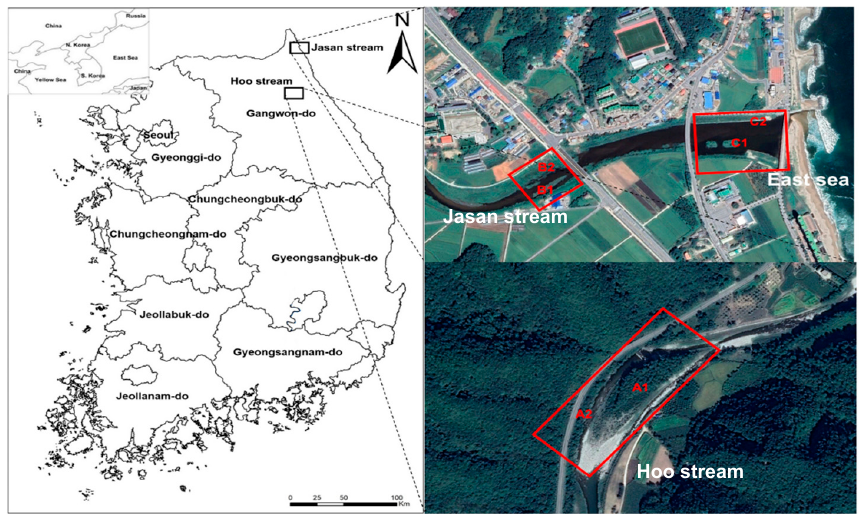
Figure 1. A map showing the study areas. A1: gravel bar of mountain gravel bed river, A2: riparian zone of mountain gravel bed river, B1: sand bar of lowland river, B2: riparian zone of lowland river, C1: sand bar of estuary, C2: riparian zone of